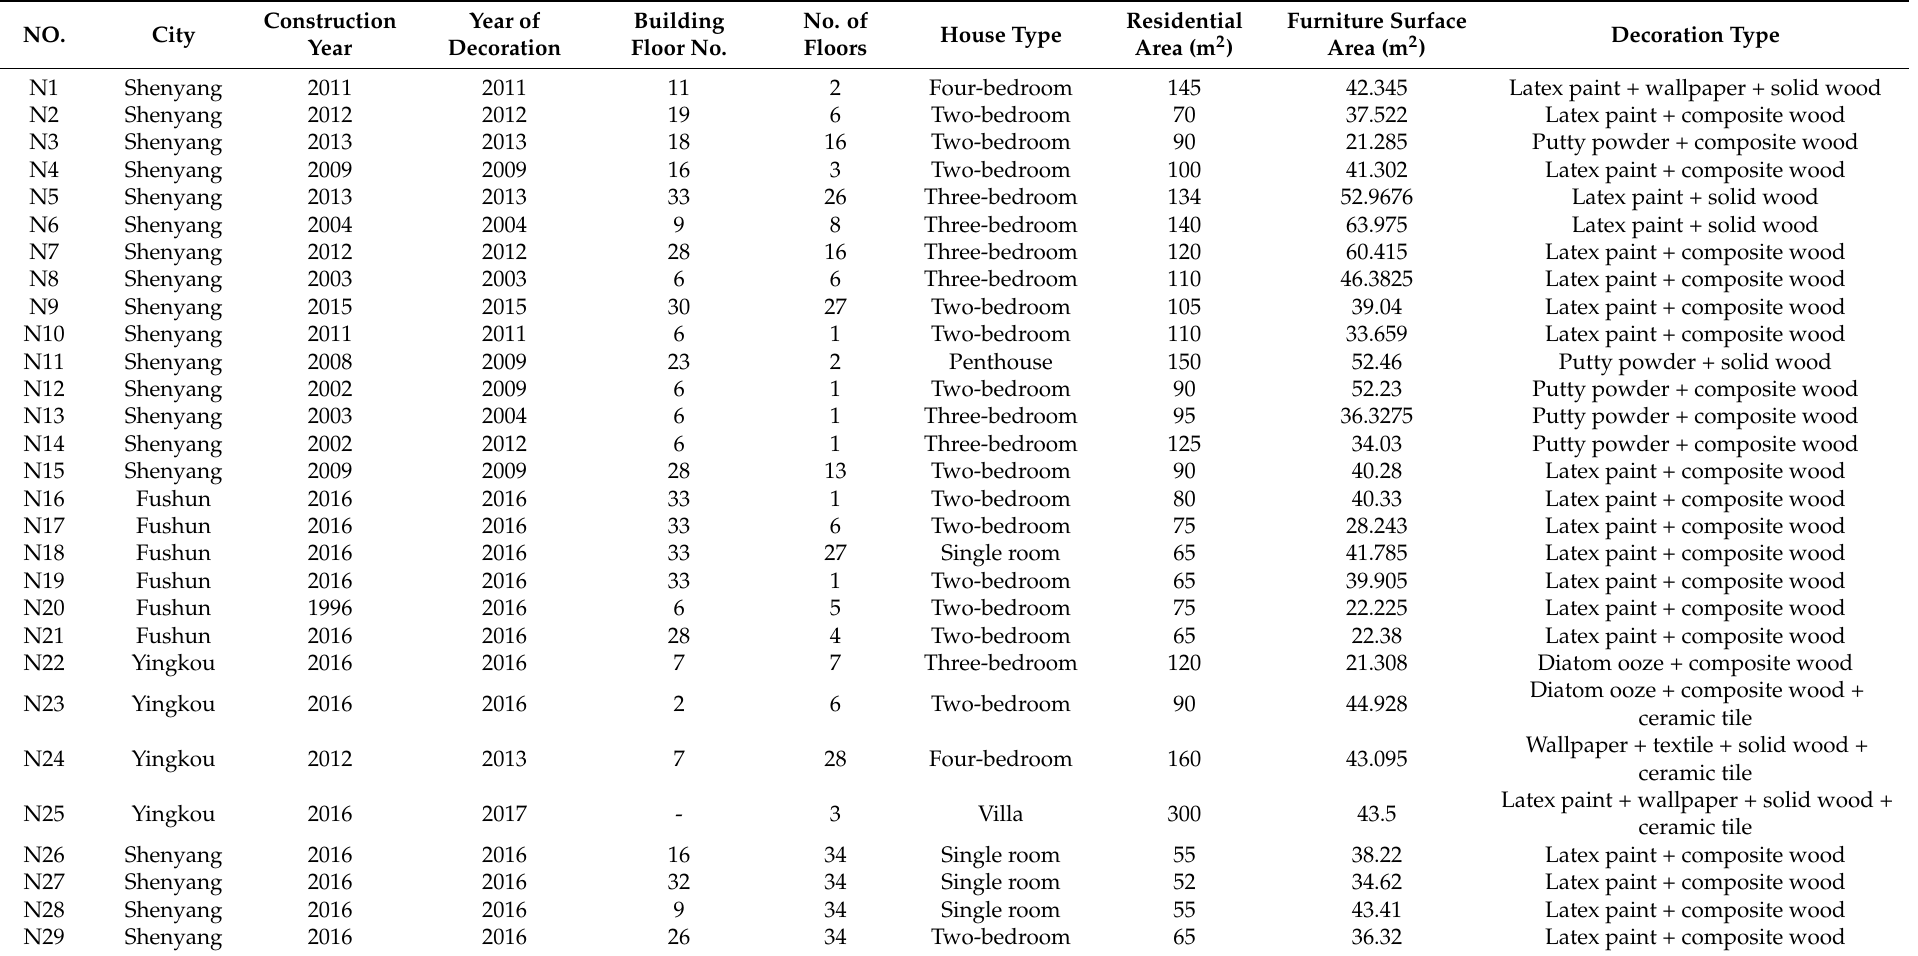
Table 1. Household